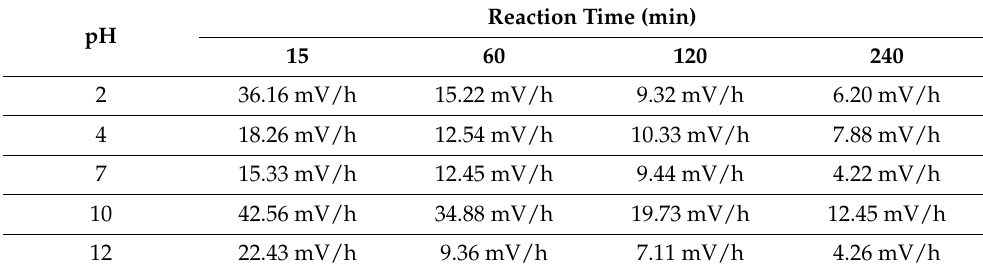
Table 3. Drift of TiN electrodes treated using different pH parameters.